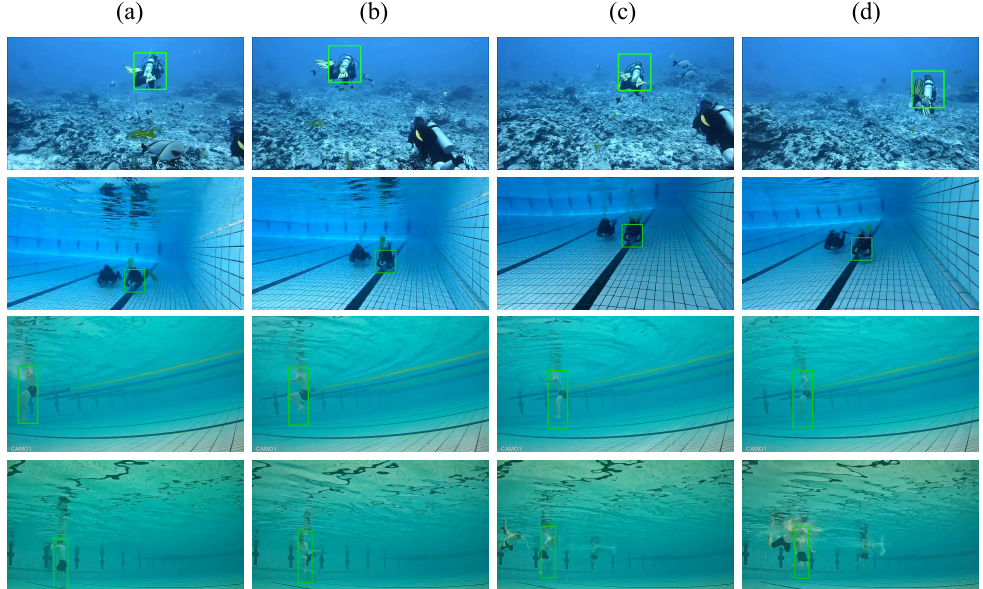
Figure 5. Underwater human body tracking test results. ( a ) The initial frame, ( b – d ) the subsequent tracking results of the